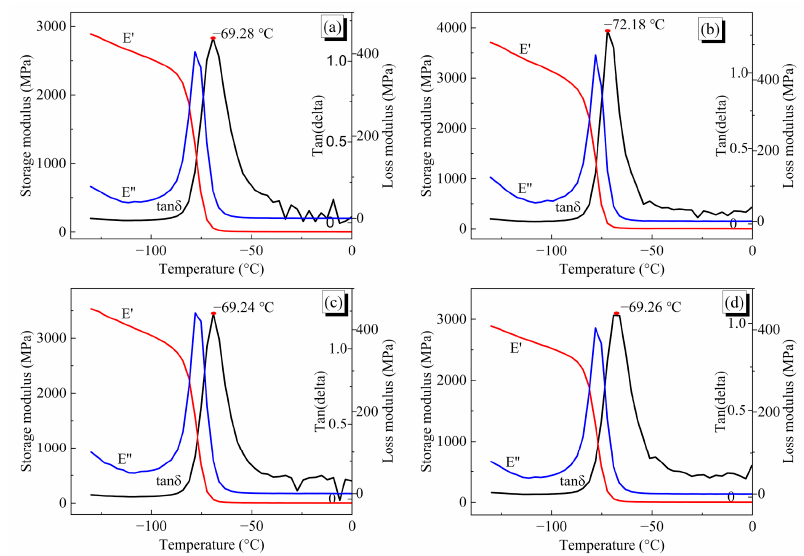
Figure 11. DMA curves of four HTPE/PEG interpenetrating polymer network binders. ( a ) S-N, ( b ) S-H, ( c ) S-T and ( d ) S-I.